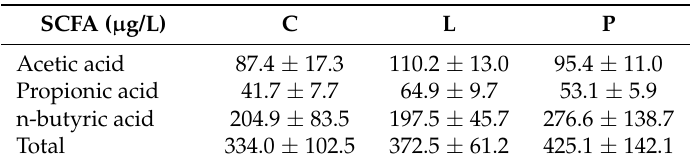
Table 9. Short chain fatty acids (SCFA) in the cecal content of laying hens at the last day of the experiment ( n = 10).